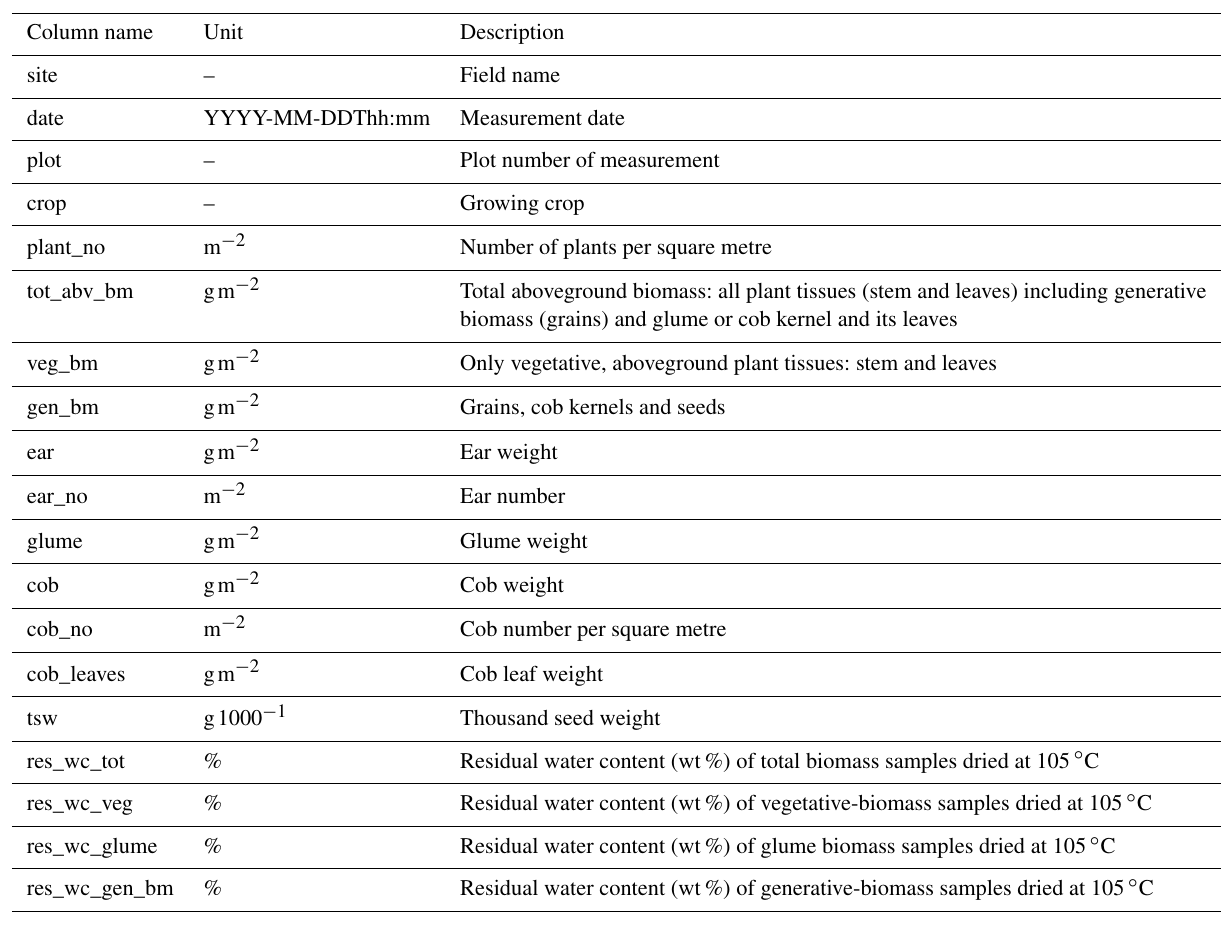
Table 14. Determined biomass variables and data description (biomass.csv).